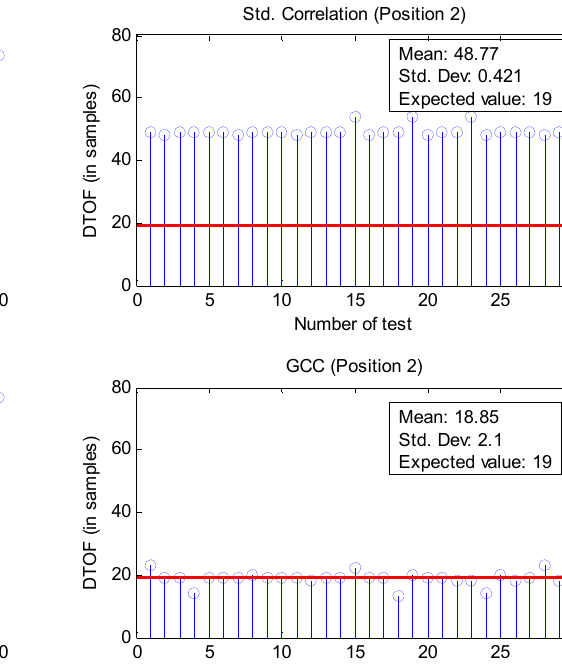
Figure 15. DTOAs measured in positions 1 and 2 when emit beacons 1 and 2 (Figure 12) using standard correlation (CC) and